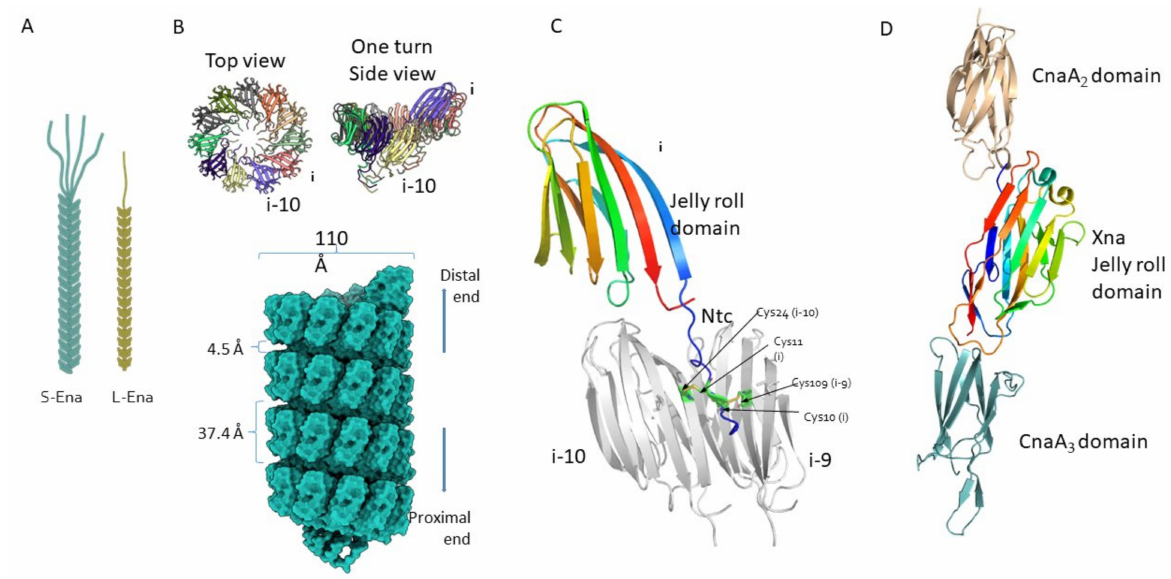
Figure 2. Architecture of the Ena fibers. ( A ) Illustration of S-Ena and L-Ena fibers with staggered and ladder-like arrangements of Ena subunits, respectively. In their termini distal to the endospore, the S-Ena fiber has ~4–5 ruffles (thin filamentous extensions of ~4 nm diameter), while the L-Ena has a single ruffle. ( B ) Surface representation of the atomic model of four helical turns of the S-Ena. Side and top view of one S-Ena helical turn featuring a ribbon representation of β –strands. ( C ) Three connected Ena subunits (as viewed from the central axis of the fiber or exposing the interior) highlighting the jelly roll domain and the N -terminal connector (Ntc) (PDB ID 7A02). Arrows point to Cys10, Cys11 of the Ntc from ith subunit that is involved in the disulphide linkage with Cys109, Cys24 of the i-9th and the i-10th subunits, respectively. Reprinted from [29].( D ) Example of Gram-positive pilin with its Cna domains. Shown here is BcpA, the major pilin of B. cereus vegetative pili (PDB ID 3KPT), highlighting the CnaA 2 , CnaA 3 , and Xna domains in light orange, light cyan, and rainbow, respectively [35]. The CnaA domains are composed of two juxtaposed β -sheets of 3–4 strands each, while the Xna domain with a jelly roll topology consists of β -sheets of four to five strands